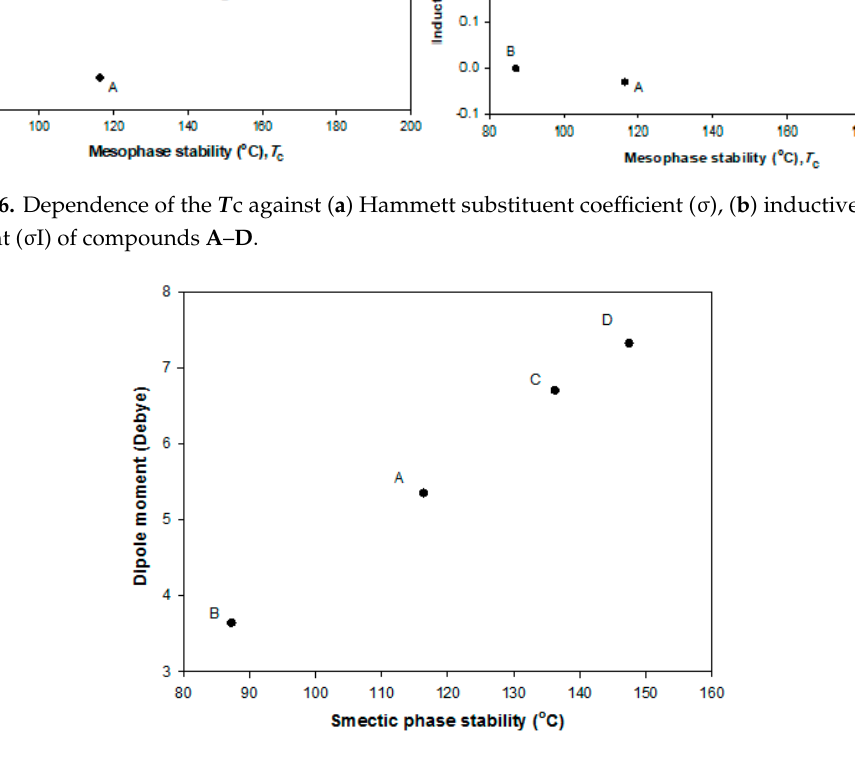
Figure 7. Dependence of the T SmA against the dipole moment µ of compounds A – D .